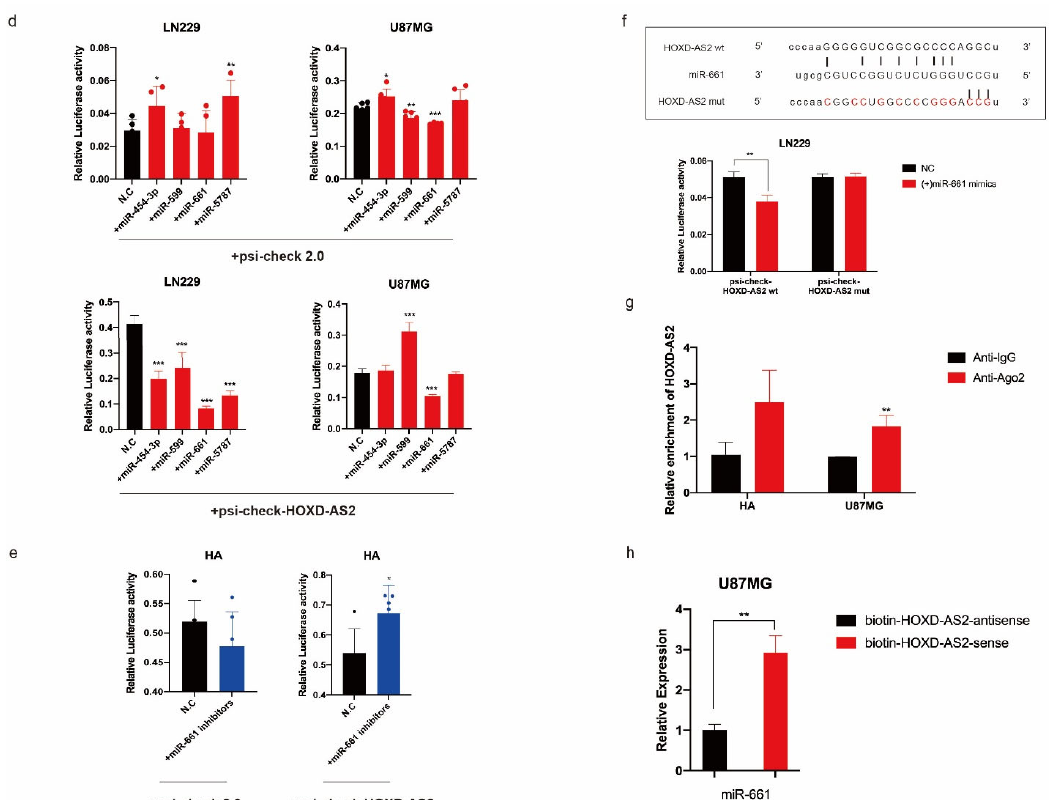
Figure 4. miR ‐ 661 degraded HOXD ‐ AS2 at post ‐ transcriptional level. ( a ) Flow chart provided for screening of potential miRNAs, which affected the expression of HOXD ‐ AS2 in gliomas. ( b ) RT ‐ qPCR demonstrated the expression of predicted miRNAs in astrocyte and glioblastoma cell lines. ( c ) miRNAs mimics were transfected into glioblastoma cell lines LN229, A172 and U87MG to inves ‐ tigate the expression of HOXD ‐ AS2 by RT ‐ qPCR. ( d ) Luciferase activity assays were performed in LN229 and U87MG cells, which were transfected with psi ‐ check2.0 vector and miRNAs mimics, psi ‐